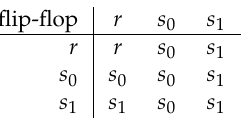
Figure 1. Composition (multiplication) tables of semigroups (computational structures). The flip-flop is the semigroup of a 1-bit memory device ( r —reading the content, s 0 , s 1 —storing bit 0 and bit 1 destructively). Z 3 is a modulo-3 counter, i.e., an odometer with only three possible